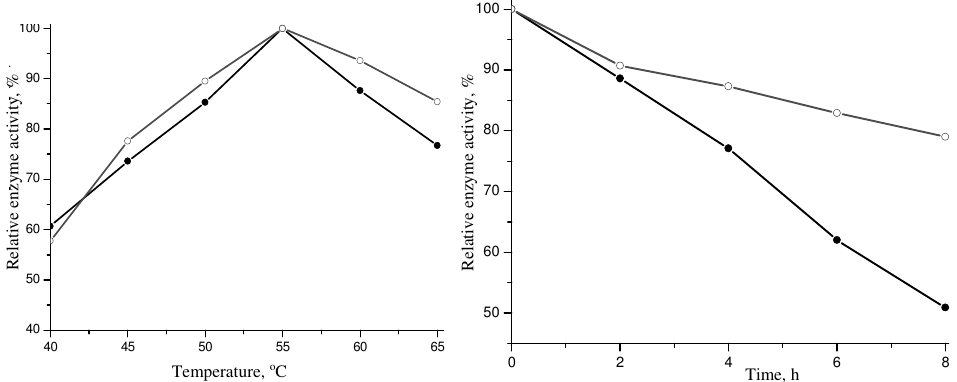
Figure 4. Effect of temperature on the activity of free (a) and immobilized (b) enzymes